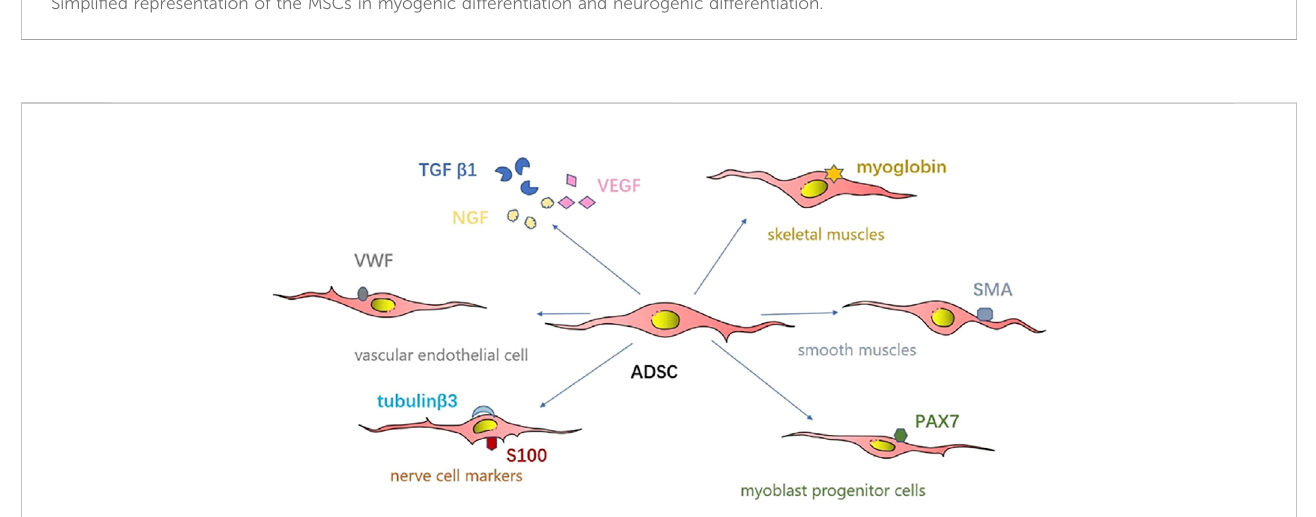
Simpli fi ed representation of the mechanism of ADSCs therapy.